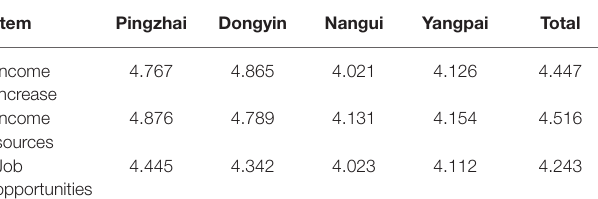
TABLE 6 | Means analysis of economic empowerment perception.